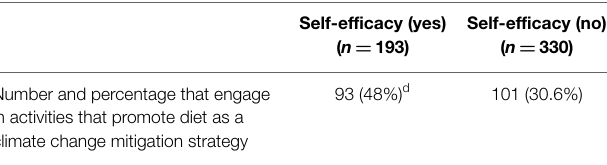
TABLE 5 | Number and percentage of survey participants that engage in activities that promote diet as a climate change mitigation strategy based onself-efficacy(comfortable,verycomfortable)inpromotingaplant-based diet a,b,c . Self-efficacy (yes) ( n = 193) Number and percentage that engage in activities that promote diet as